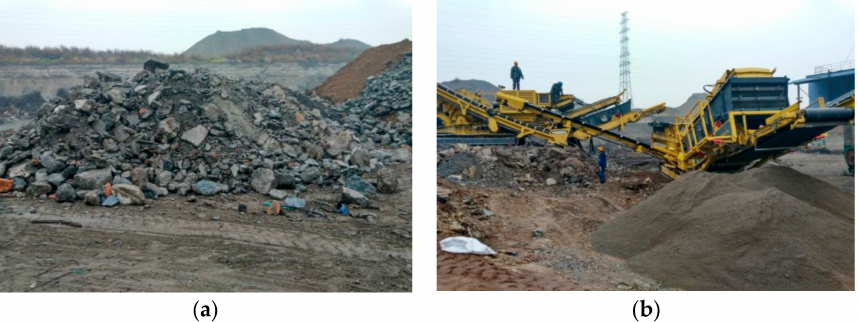
Figure 2. The processing of recycled concrete aggregate (RCA). ( a ) The construction waste; ( b ) The recycled concrete aggregate.